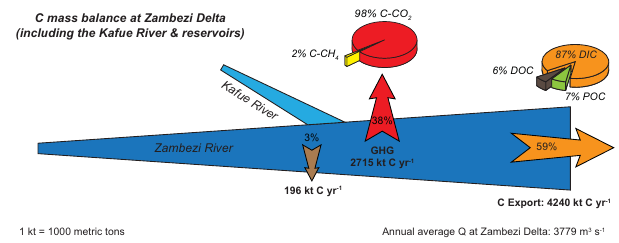
Figure 10. Carbon mass budget for the Zambezi River. The GHG emission component was calculated for a total surface area of 10576km 2 , of which the Zambezi mainstem represents 18%, the Kafue River accounts for 3%, the Itezhi Tezhi and Kafue Gorge reservoirs sum up to approximately 4%, and the Kariba and Cahora Bassa reservoirs represent 75% (see Table